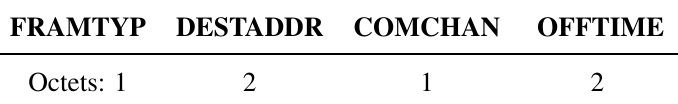
Table 2. ACK/NACK with data frame format.